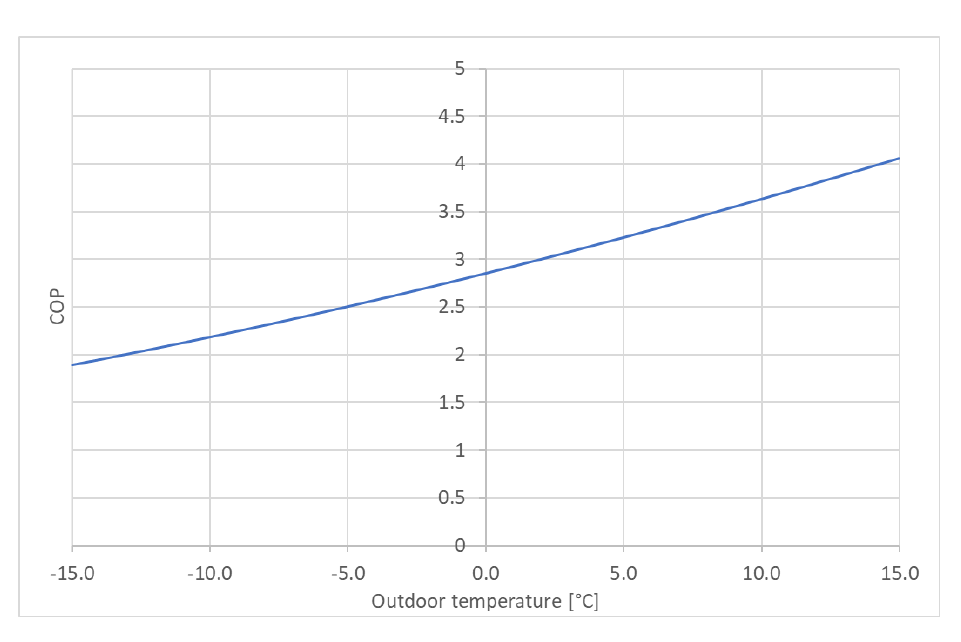
Figure 2. Behavior of the heat pump (HP) versus the outdoor temperature.